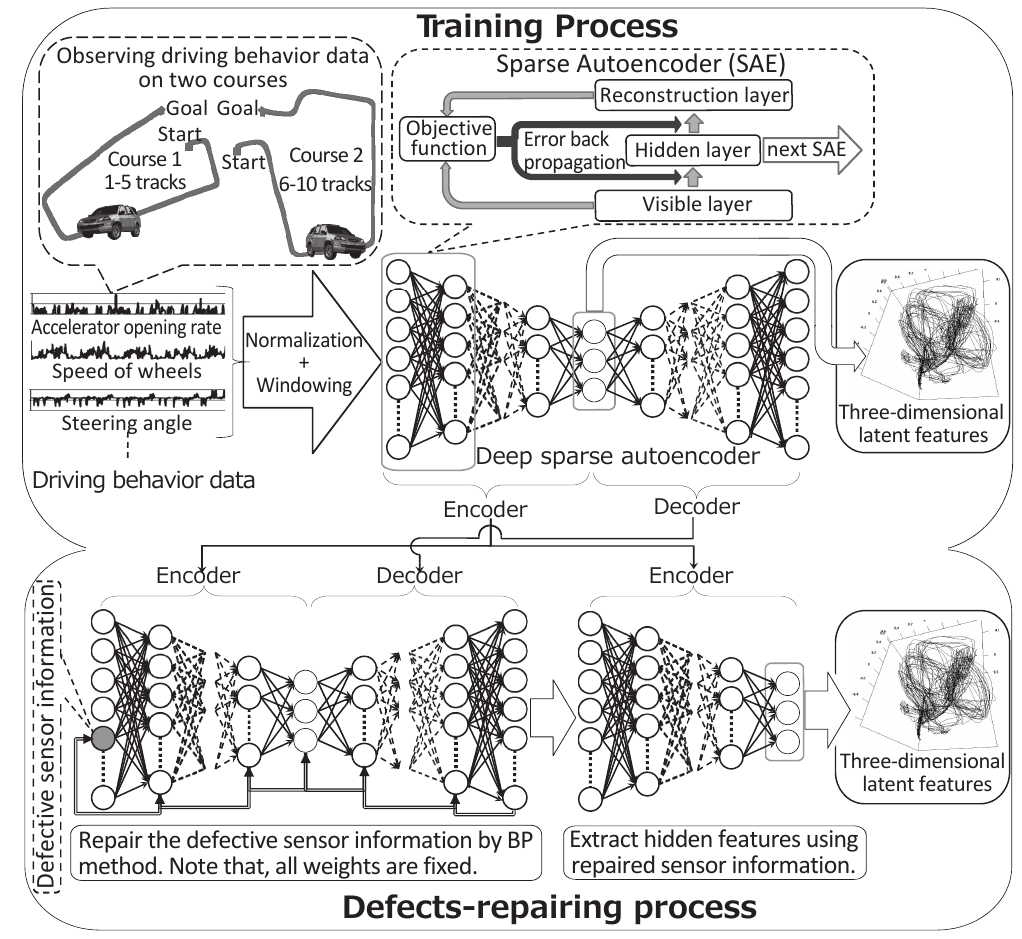
Figure 1. Feature extraction and defect-repairing processes of the deep sparse autoencoder (DSAE), which repairs defects in sensor time-series data by using a back propagation (BP)